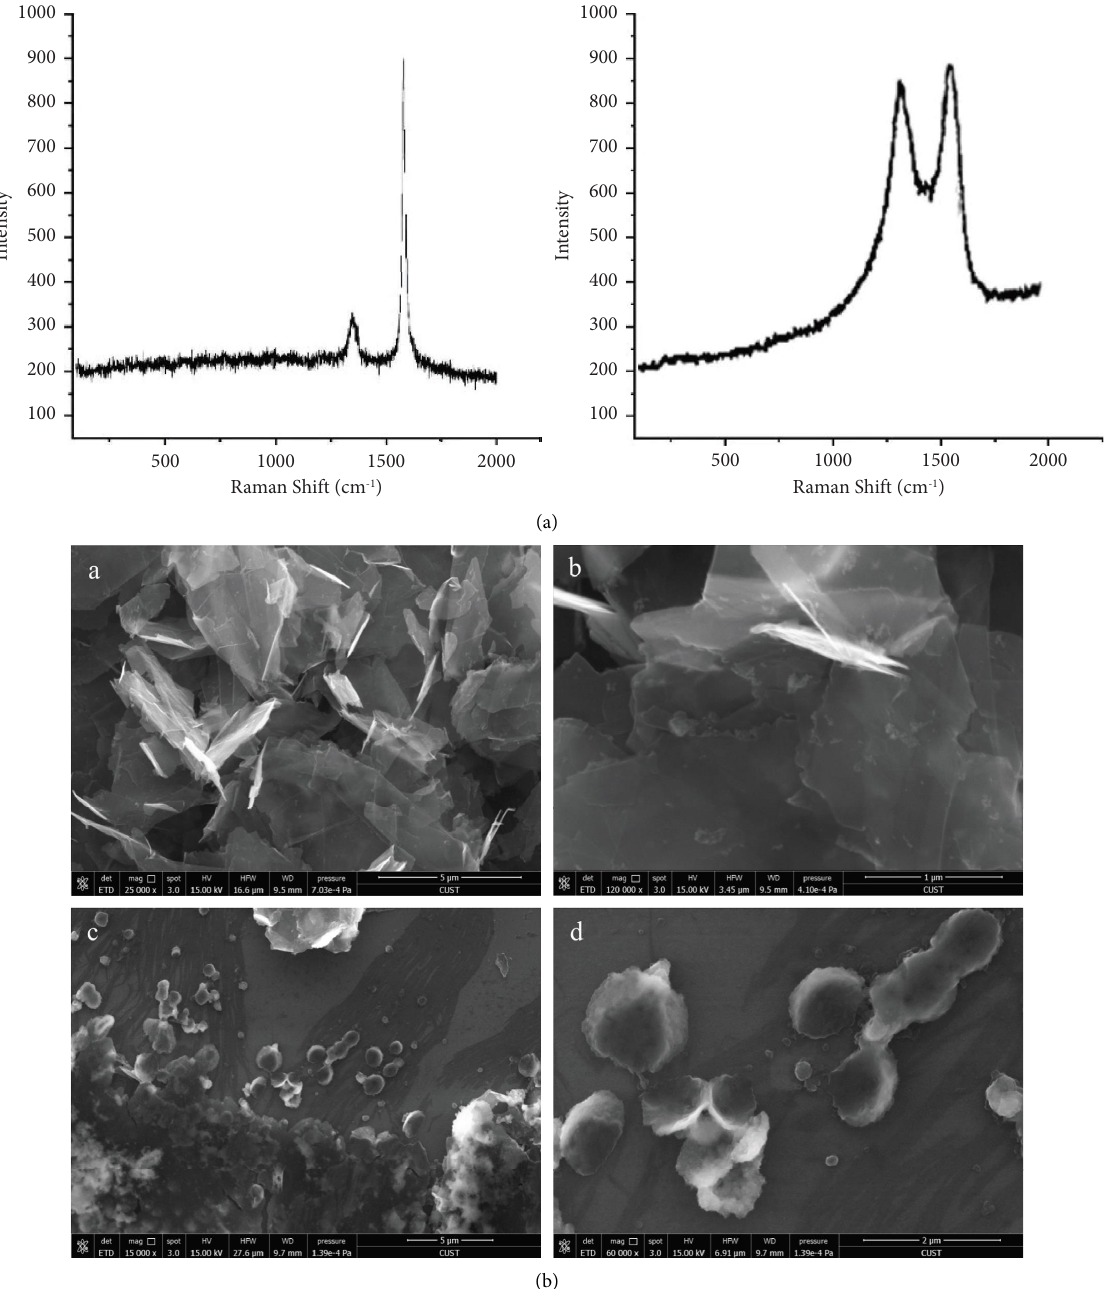
Figure 1: Characterization of graphene oxide. (a) Raman spectra of graphene oxide before centrifugation (left) and after centrifugation (right); (b) (A) and (B) are the SEM images of graphene oxide before ultrasound, and (C) and (D) are the SEM images of graphene oxide after